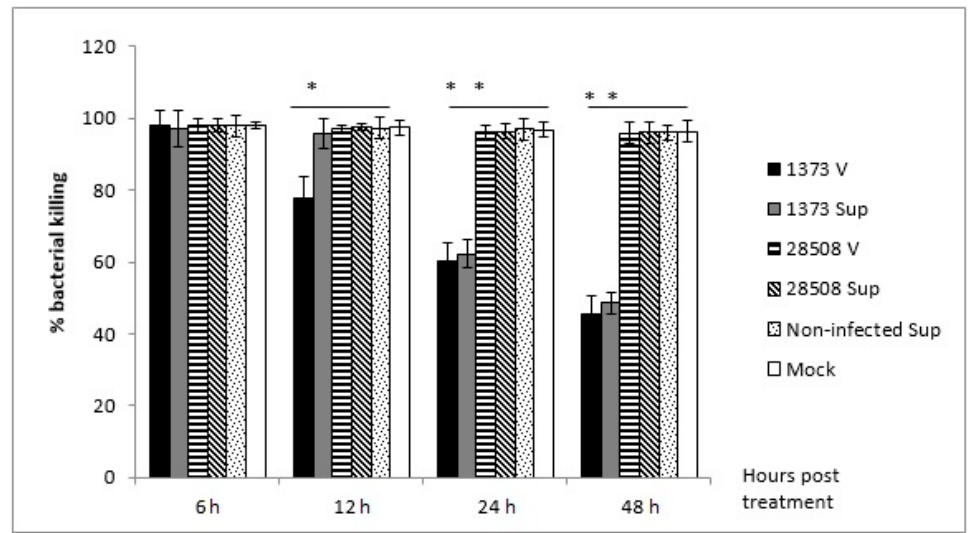
Figure 3. The effect of BVDV strains and the corresponding infected-MDM supernatants on macrophage bactericidal activity for 48 h post-treatment. Sup: supernatant (indirect effect), V: virus (direct effect). *: p < 0.05 (>95% confidence), **: p < 0.01 (>99% confidence).